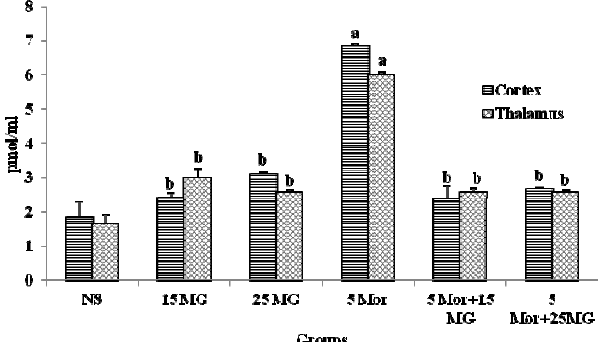
Figure 3. The expression of cAMP protein in thalamus and cortex of control group (normal saline), mitragynine (15 mg/kg, 25 mg/kg), morphine (5 mg/kg) and combination groups (5 mg/kg Mor + 15 mg/kg; 5 mg/kg Mor + 25 mg/kg) for 9 days treatment. Each column represents expression of cAMP in pmol/ml. Values are statistically siginficant at p < 0.05. a: Morphine alone treated group when compared with control group and b: mitragynine and combination treated group compared with morphine alone ( p <